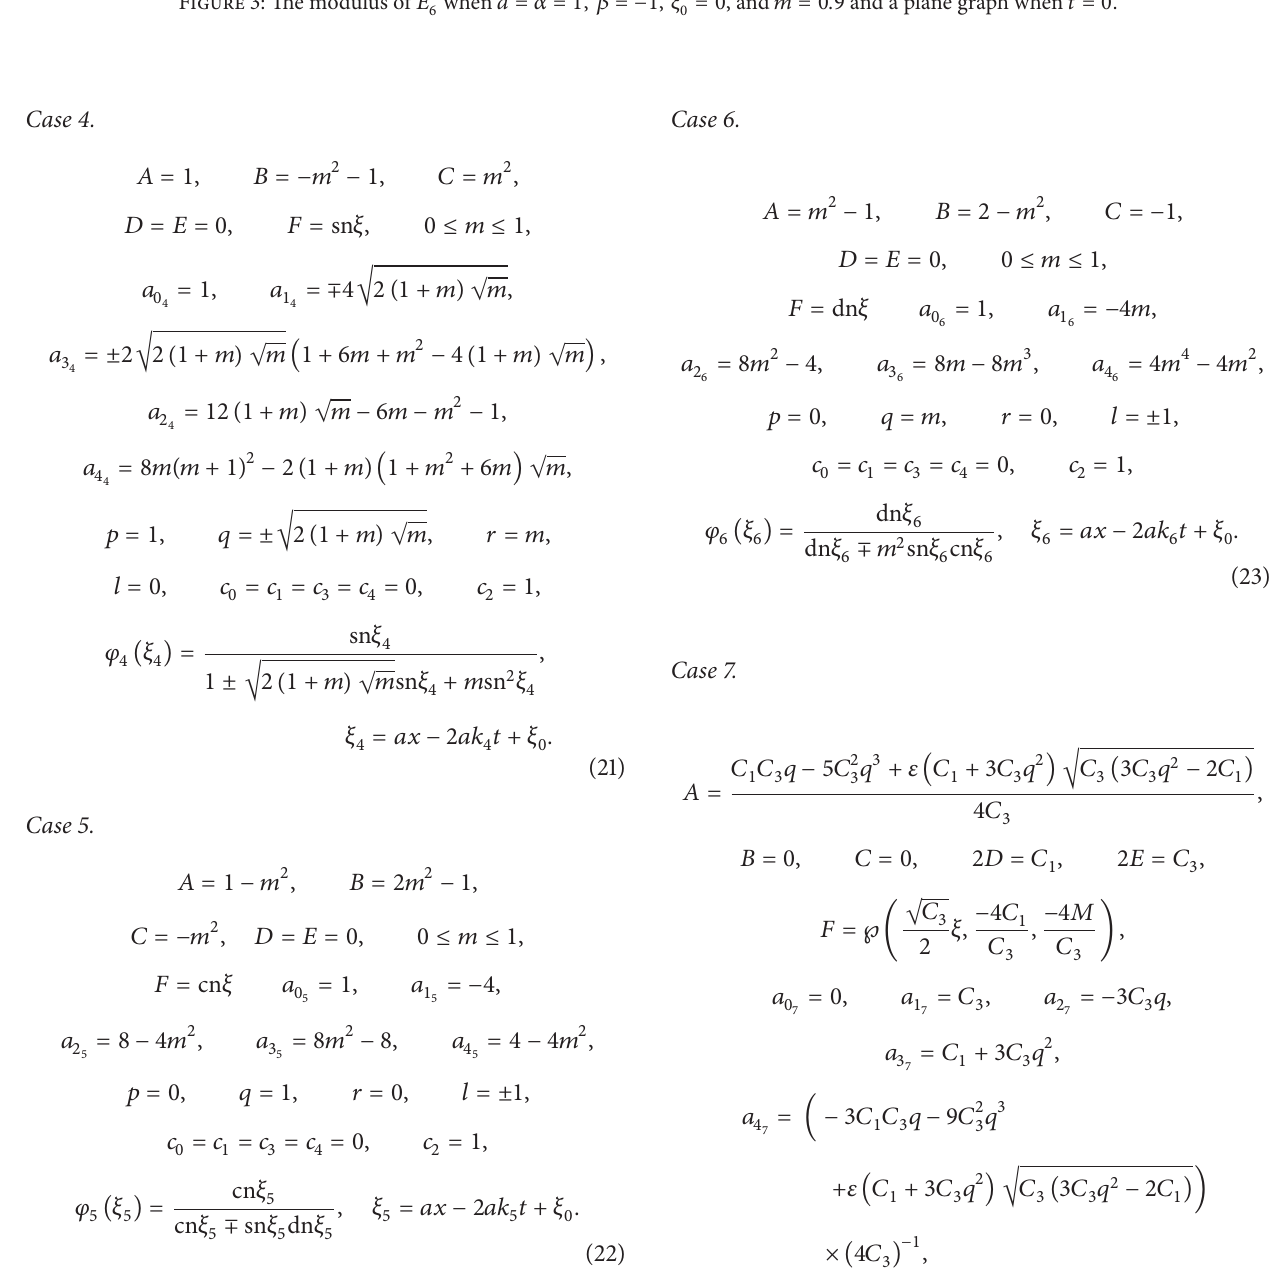
Figure 3: The modulus of 𝐸 6 when 𝑎 = 𝛼 = 1 , 𝛽 = −1 , 𝜉 0 = 0 , and 𝑚 = 0.9 and a plane graph when 𝑡 = 0 .